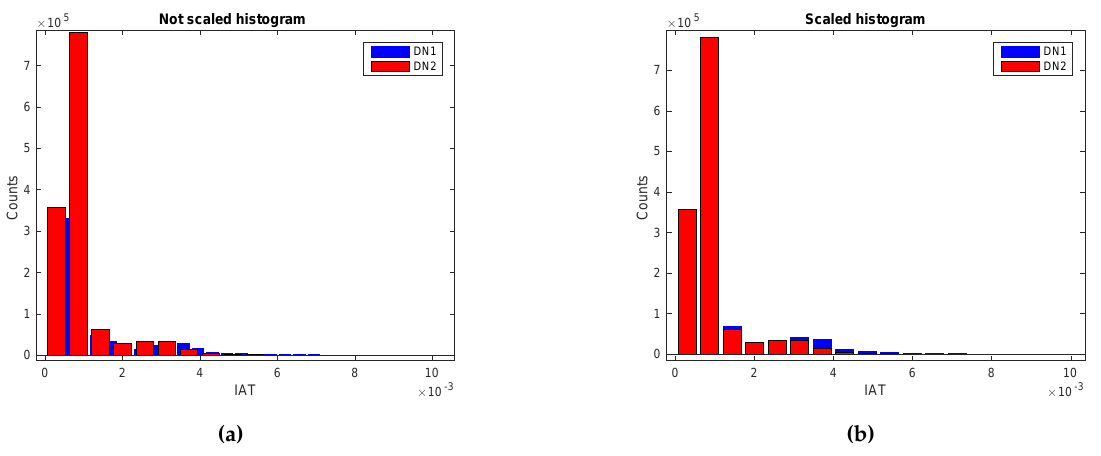
Figure 2. Effect of non-scaled histograms for DN1 and DN2 with 500 bins. Due to their different minimum and maximum values, the bins of the histograms from DN1 and DN2 do not use the same interval values. ( a ) Non-scaled histograms; ( b ) Scaled